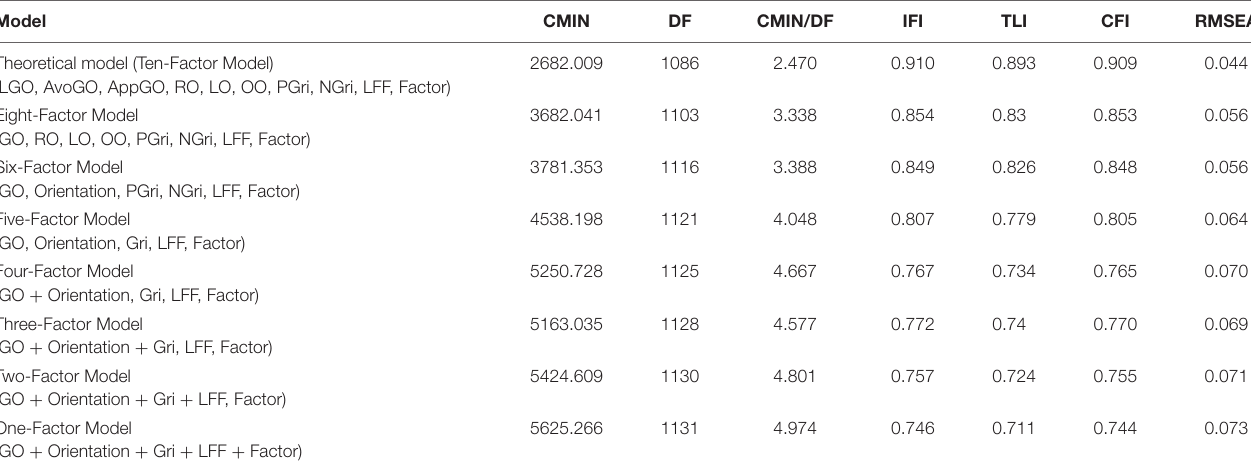
TABLE 1 | Comparison of measurement